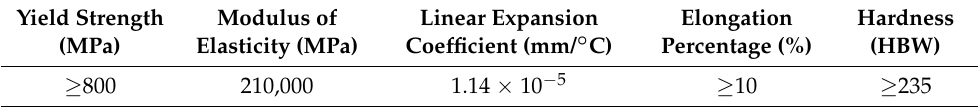
Table 1. Mechanical properties of 50 kgN rail [33]. Yield